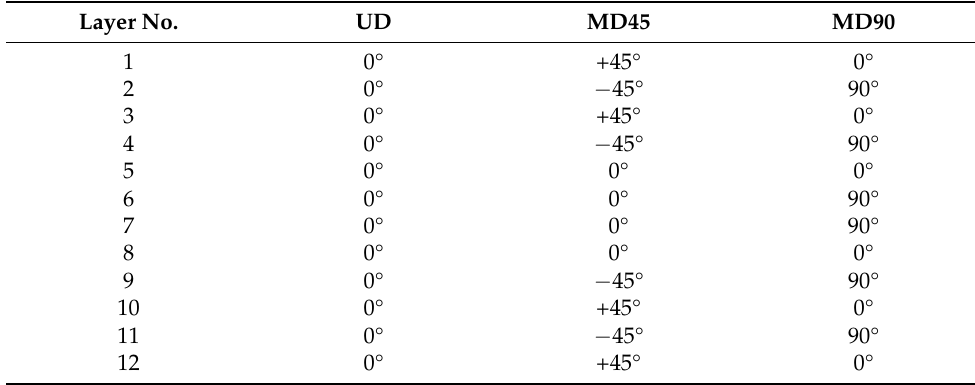
Table 2. Layer configurations for plate specimen used in